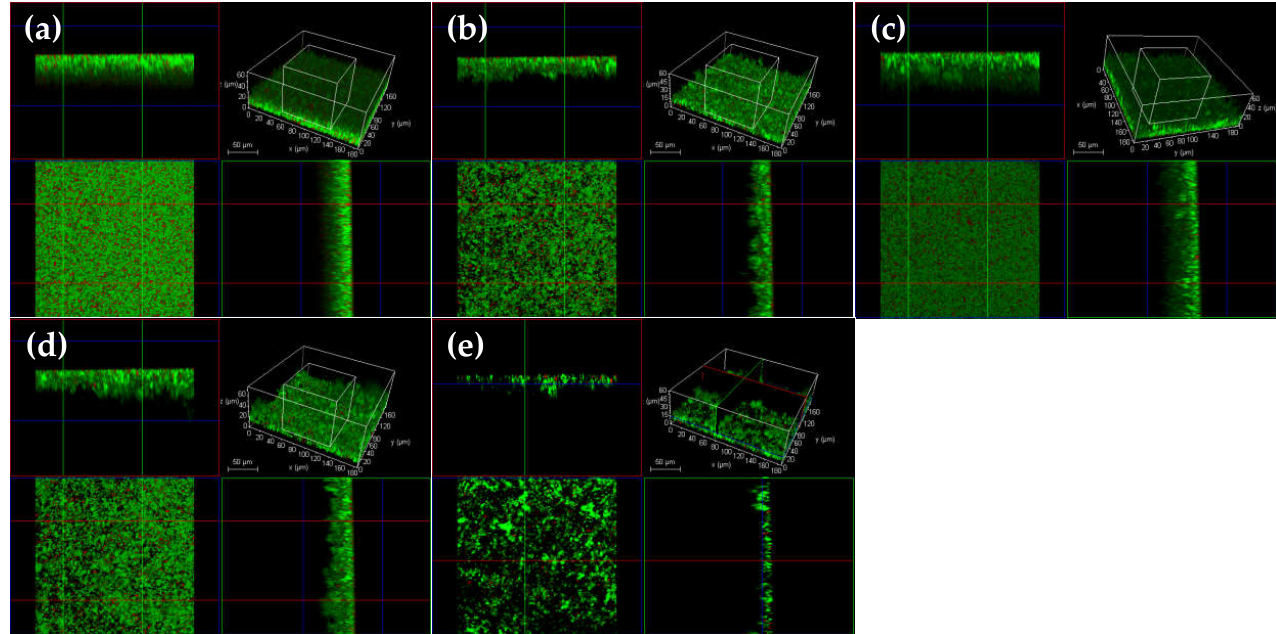
Figure 6. CLSM analysis of T. pyogenes (BMH06-3) biofilm on the silicon hydrogel lenses after the in vivo treatment of luteolin (Green: live bacteria; red: killed bacteria; black: no bacteria). ( a ) Blank control biofilm. ( b ) Ceftiofur group (1.5 mg/kg b.w). ( c – e ) Luteolin group (50 mg/kg b.w; 100 mg/kg b.w; 150 mg/kg b.w).